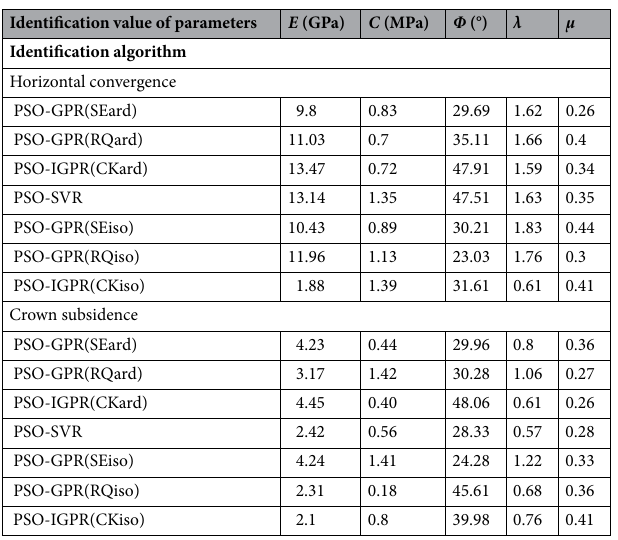
Table 8. Geomechanical parameters identified by the displacement of the rock mass around the tunnel of section LK59 + 150 ( d = 6.0 m).